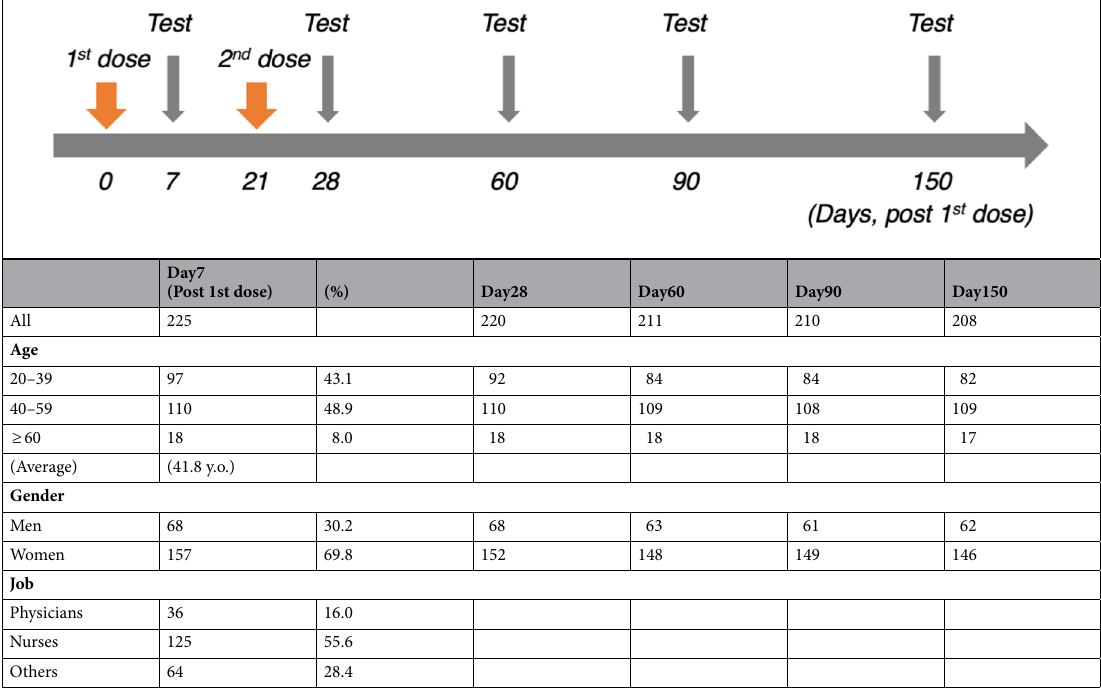
Table 1. Study protocol and demographic characteristics of the